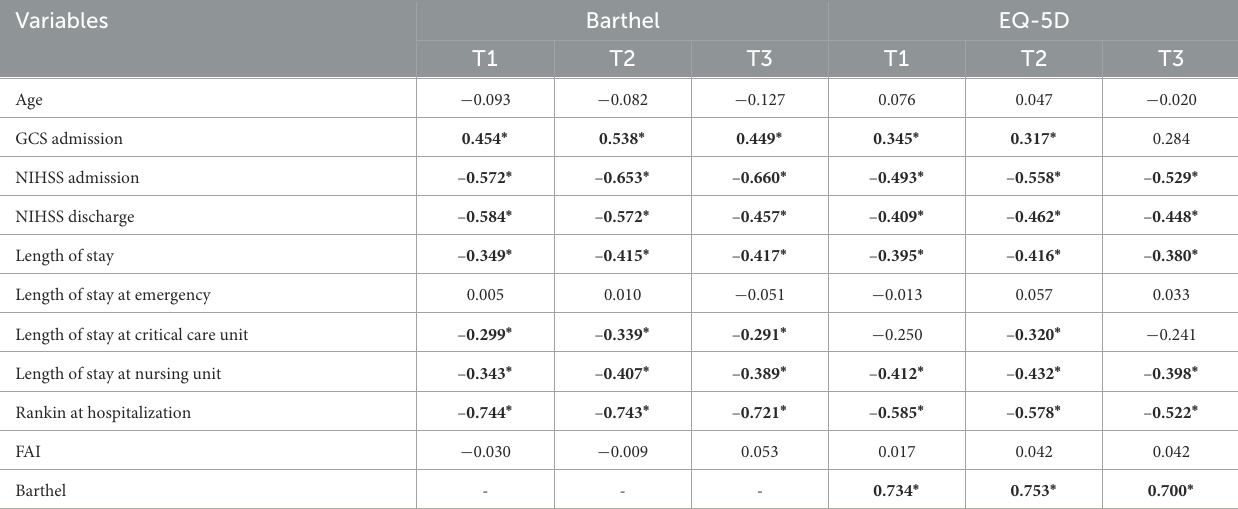
TABLE 2 Spearman’s correlation